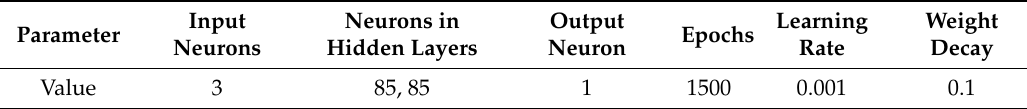
Table 1. Parameters for the neural network model.